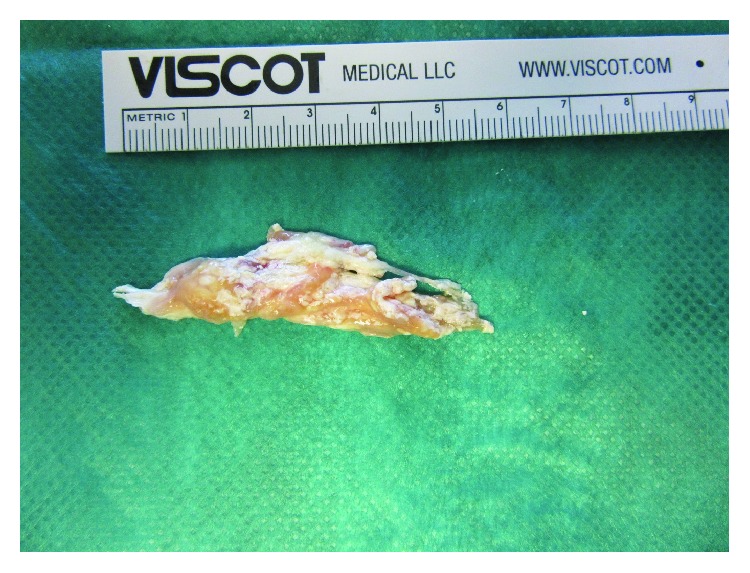
The excised tophus.